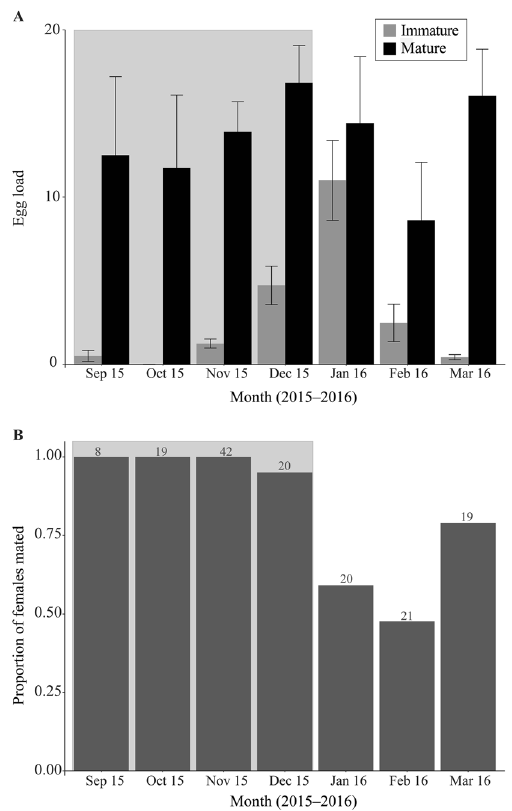
Figure 4. ( A ) The number of mature and immature eggs found from dissections of P. downsi females captured between September 2015 and March 2016 (means ± SE). ( B ) The proportion of P. downsi females captured between September 2015 and March 2016 that were found to contain sperm in at least one spermatheca. The grey box indicates the months of the host interbreeding period for both panels.